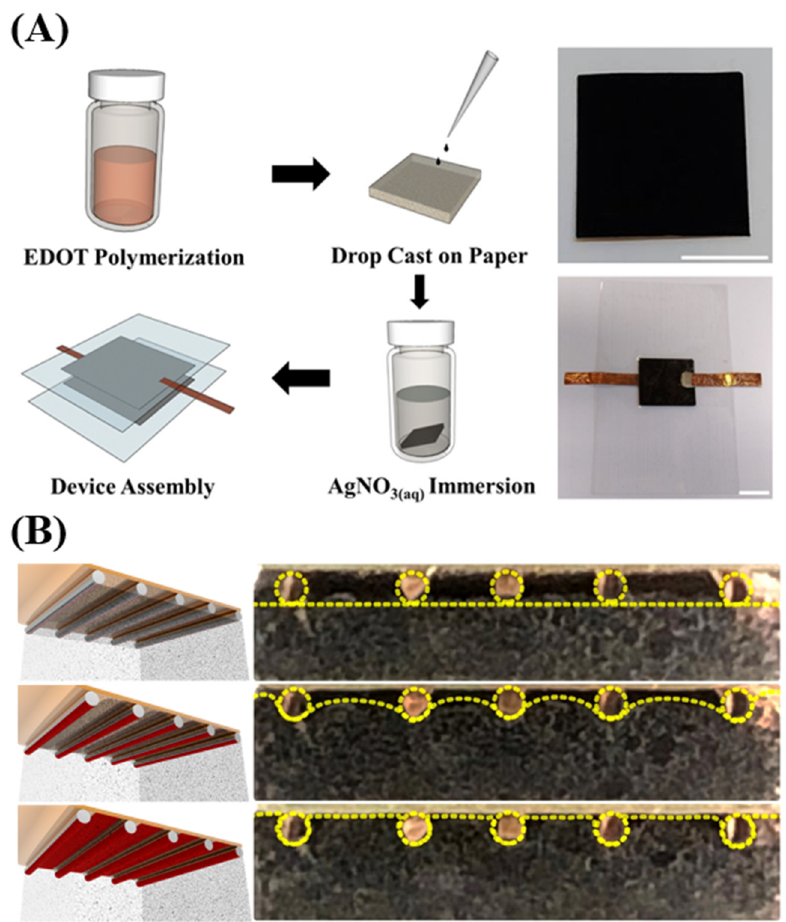
Figure 4. ( A ) Fabrication process of a piezoresistive pressure sensor made by stacking multiple pieces of silver nanoparticles–poly(3,4-ethylenedioxythiophene) (AgNP–PEDOT)-paper composite material. ( B ) An improved bulk material–electrode interface design for a sponge-based piezoresistive sensor. Adapted with permission from [27,37].